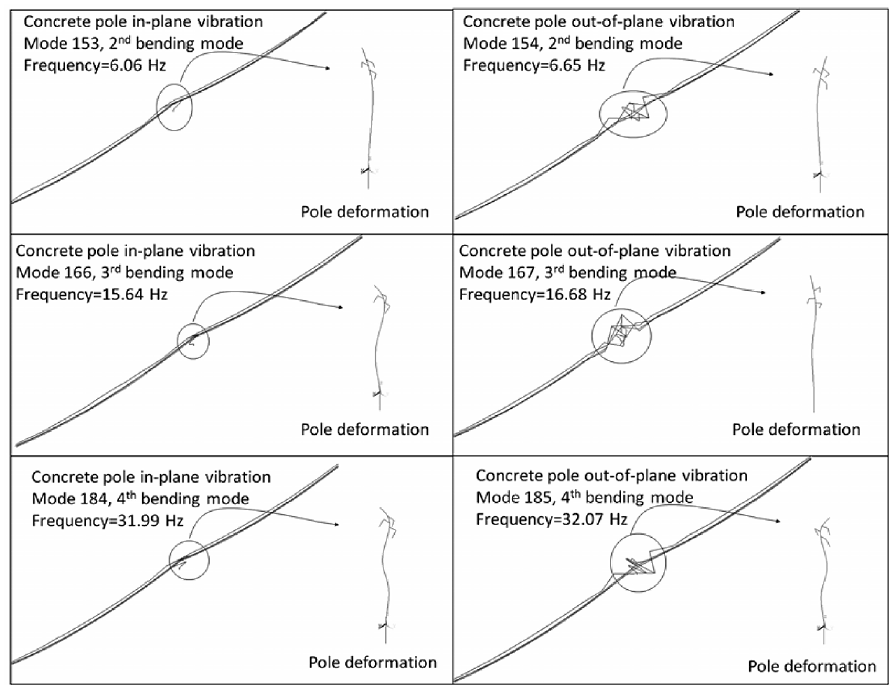
Fig. 3. Representative pole-leading modes of the coupled concrete pole-line